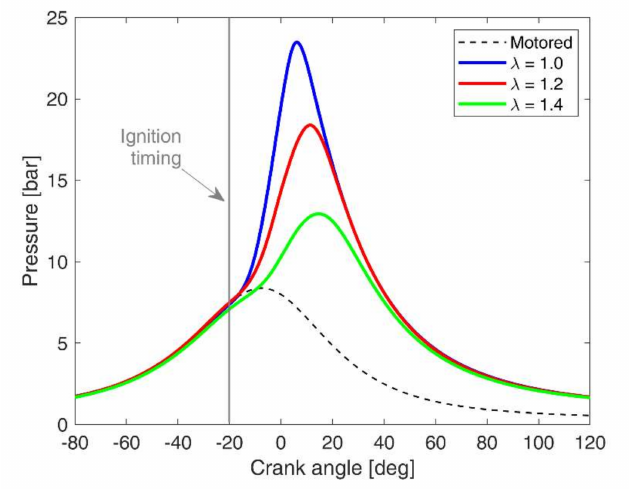
Figure 4. Pressure traces averaged on 101 consecutive cycles. For all cases, the ignition timing (IT) was 20 CAD bTDC (gray line), with V d = 28 V and T d = 300 µ